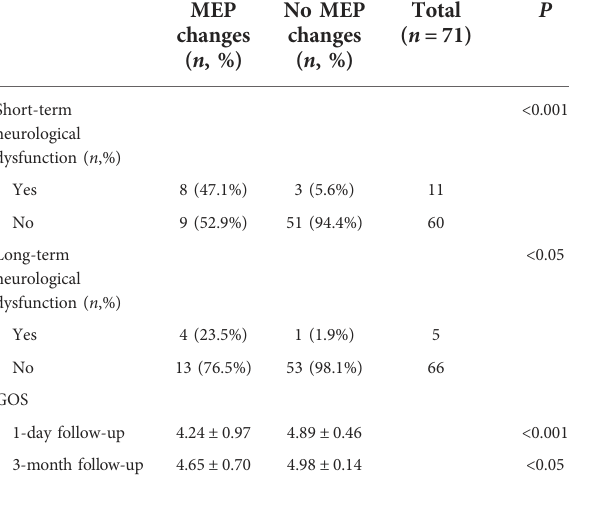
TABLE 3 Relationship between intraoperative SSEP and postoperative neurological dysfunction and GOS